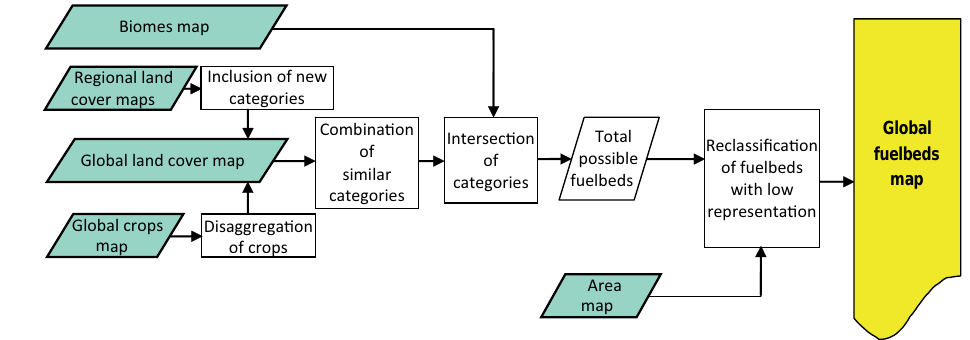
Figure 2. Flow chart of the steps performed for the generation of the